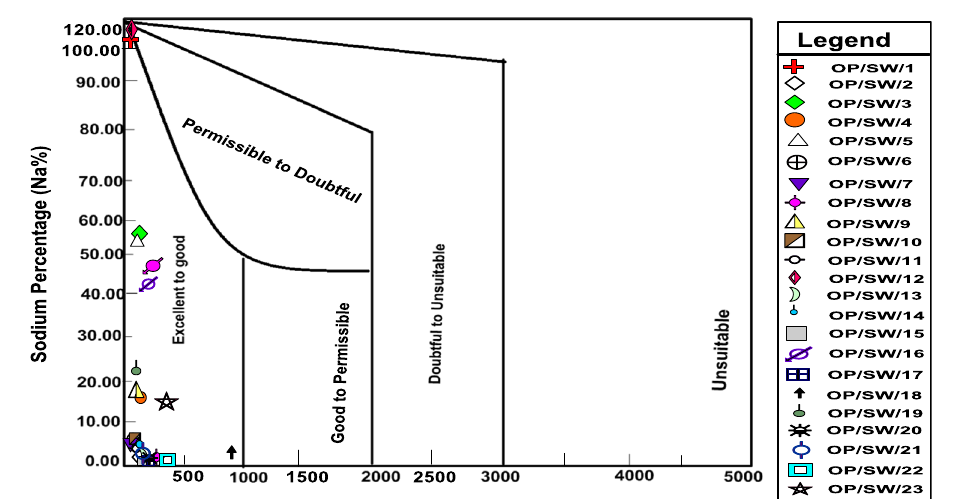
Fig. 4 Rating of water samples on the basis of electrical con- ductivity and sodium percentage (after Wilcox